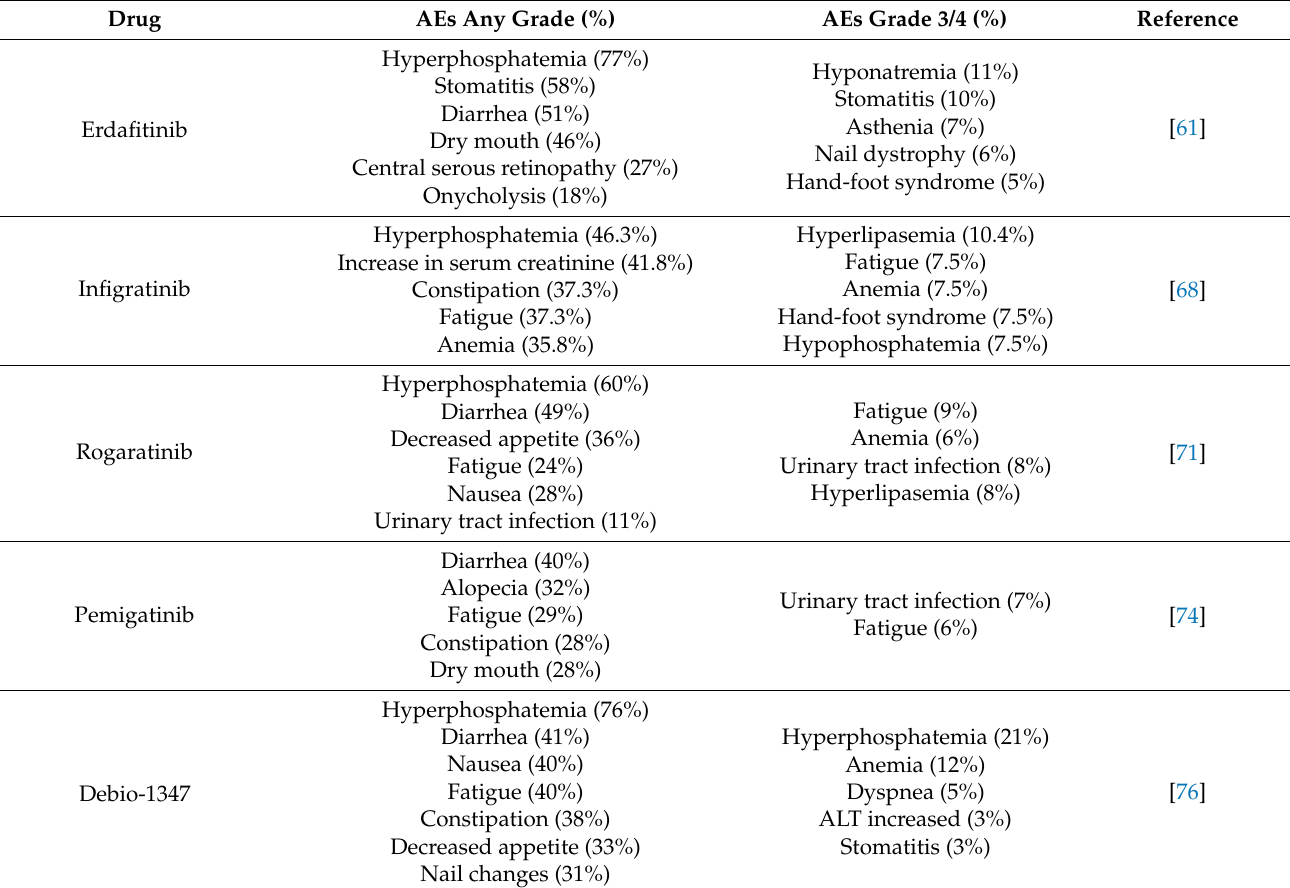
Table 3. Most common FGFR inhibitor-associated adverse events